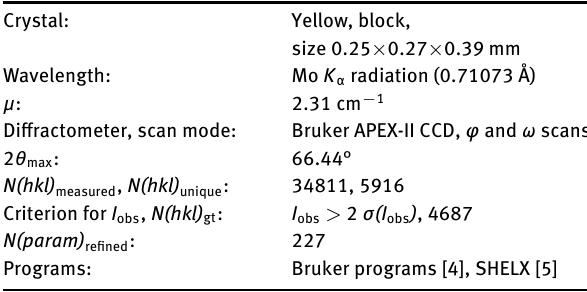
Table 1: Data collection and handling.